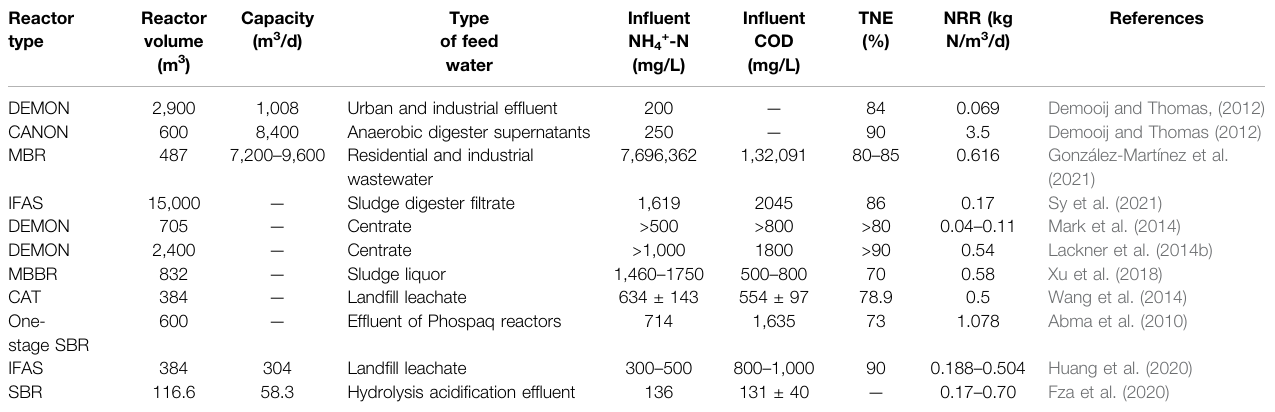
TABLE 1 | Performance of full-scale PN/A